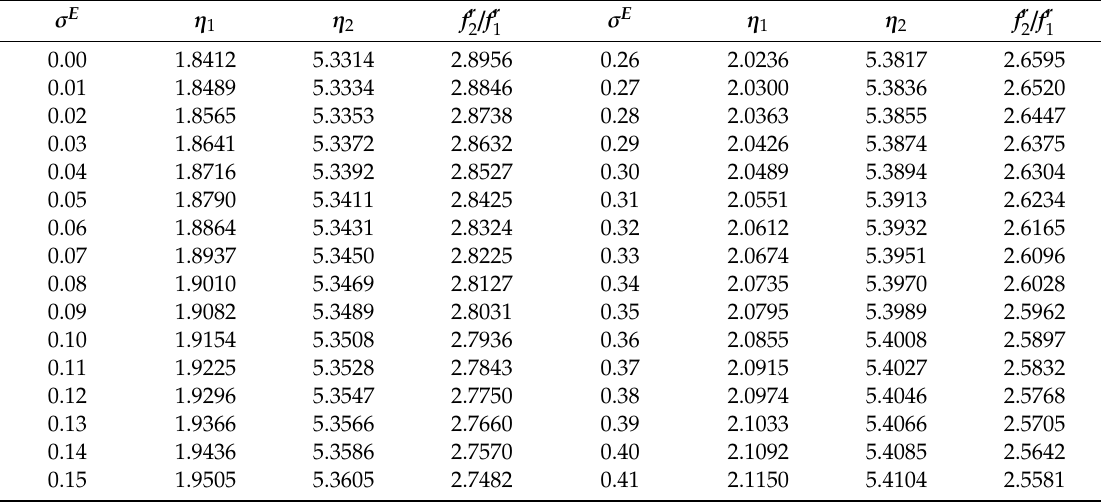
Table A3. Poisson’s ratio corresponds to the ratio of the first two resonant frequencies. σ